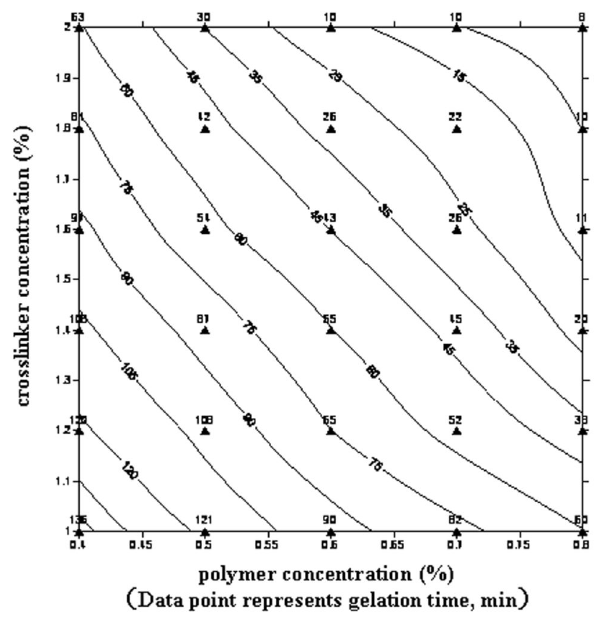
Figure 1. Contour map of gelation time.